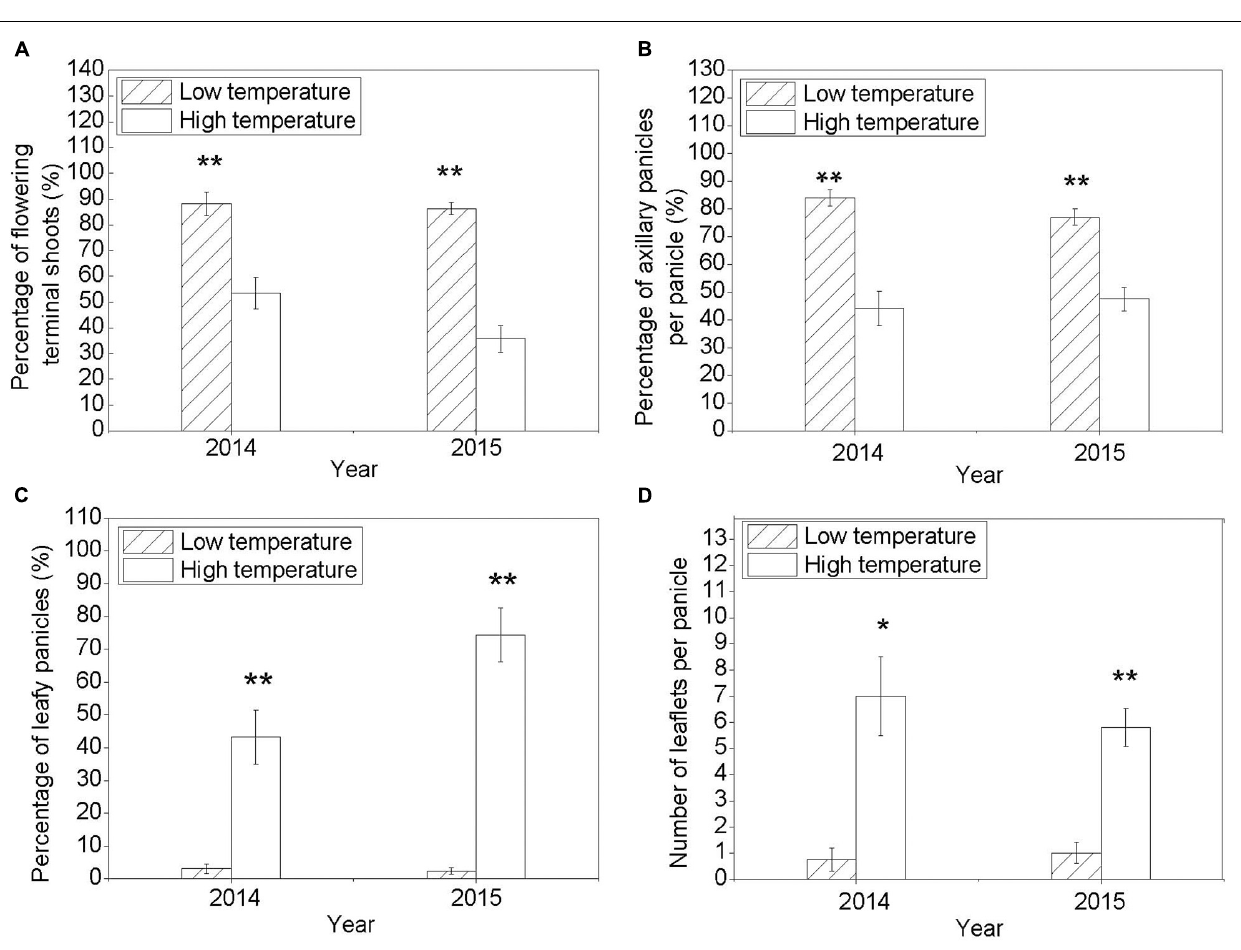
FIGURE 1 | Flowering phenotype of the litchi trees under low temperature (LT) and high temperature (HT) conditions. (A) Percentage of the flowering terminal shoots. (B) Percentage of the axillary panicles per panicle. (C) Percentage of leafy panicles. (D) Number of leaflets per panicle. Vertical bars represent standard error (SE; n = 3). Symbols above the column mean a significant difference between LT and HT treatments (Duncan’s multiple range test, * P = 0.05; ** P = 0.01).